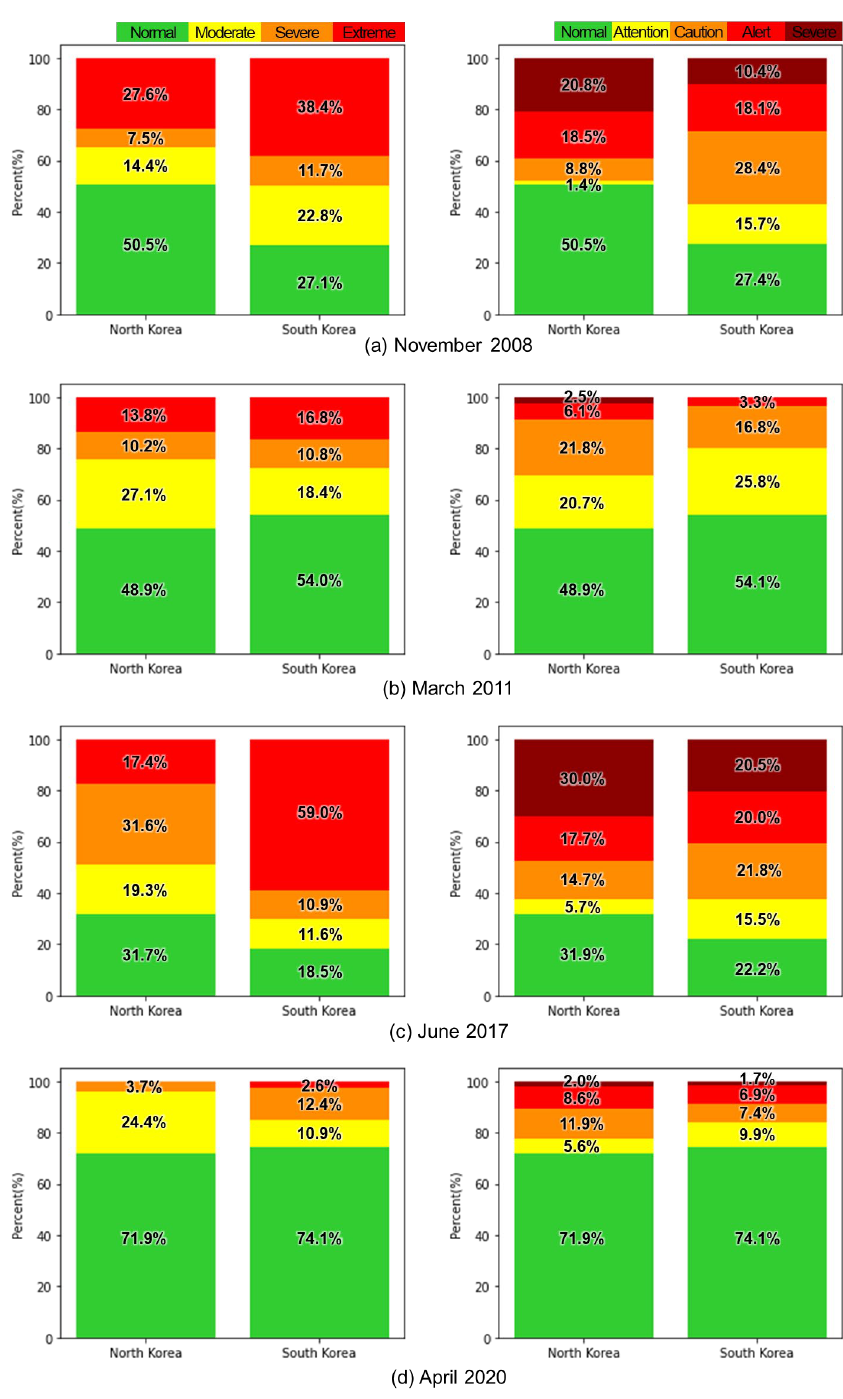
Figure 11. Percentage of meteorological drought ( Left ) and ecological drought ( Right ) levels experienced by agricultural regions in North and South Korea for ( a ) November 2008, ( b ) March 2011, ( c ) June 2017 and ( d ) April 2020.